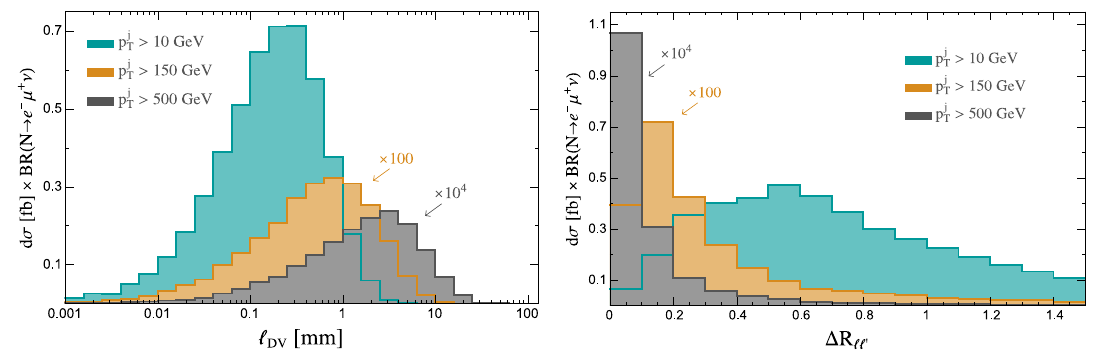
Figure 10 . Distributions for transverse displacement (left) and (cid:1) R ‘‘ 0 (right) of the two leptons originated at the DV for the process pp The neutrino parameters are taken to m N = 12 GeV,